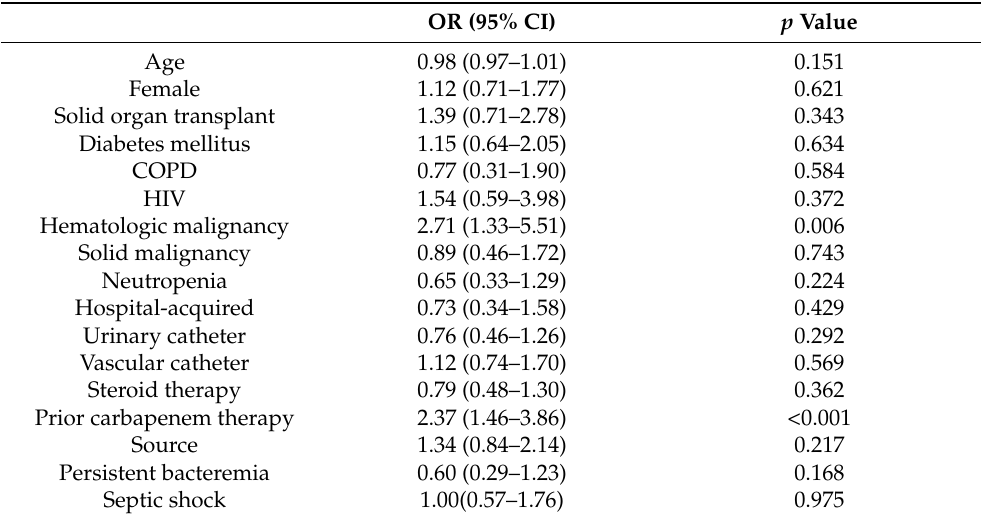
Table 2. Logistic regression model of variables evaluated as predictive factors of carbapenem-resistant Pseudomonas aeruginosa bloodstream